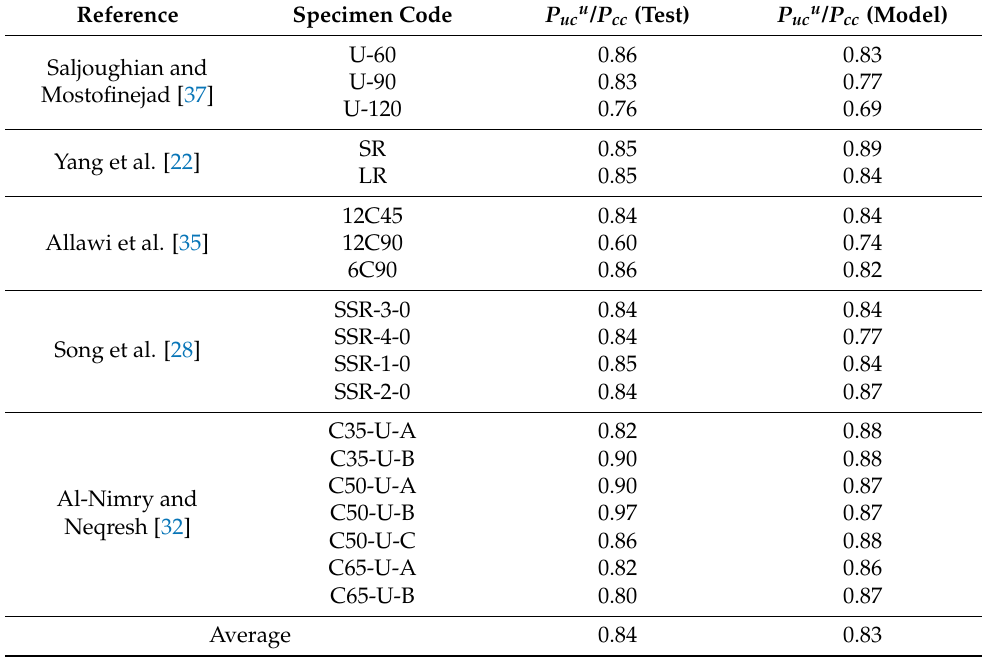
Table 8. Comparison between tested and predicted failure strength ratios of unwrapped RC columns tested under different eccentric loading